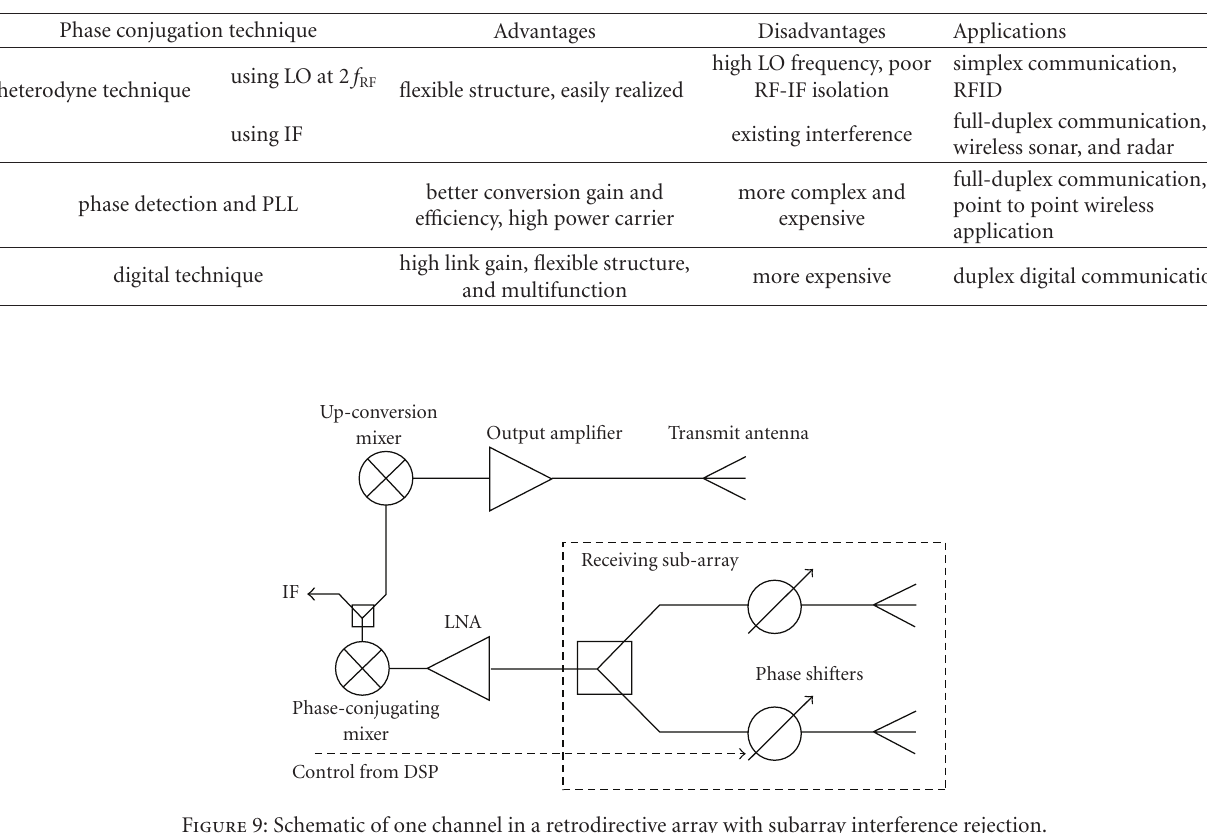
Figure 9: Schematic of one channel in a retrodirective array with subarray interference rejection.